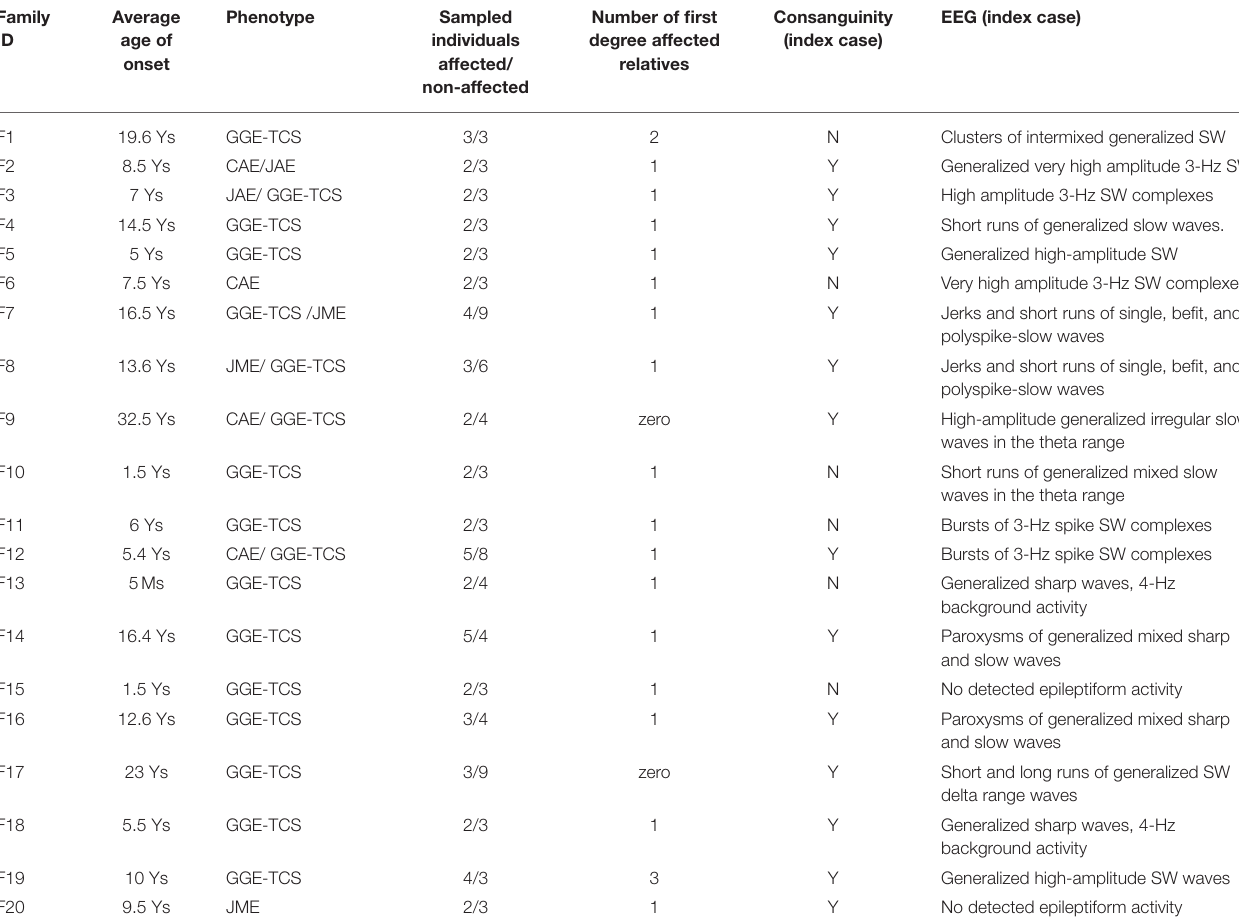
TABLE 1 | Description of the cohort. Family